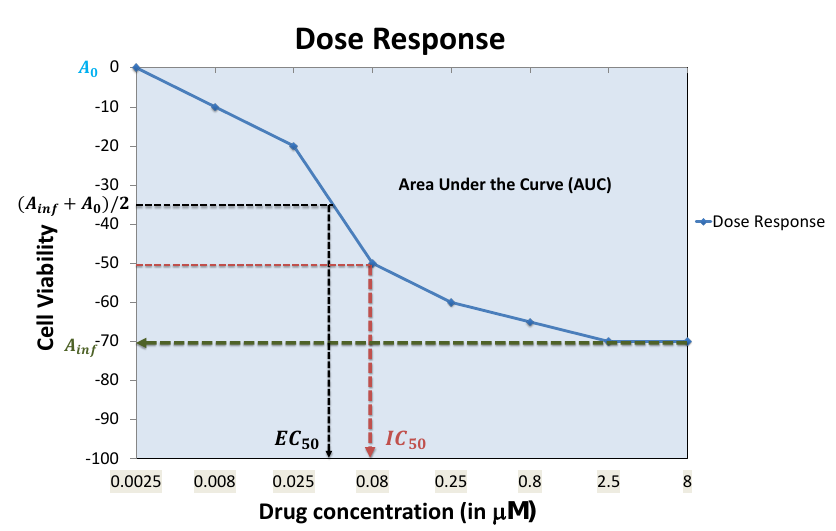
Figure 2. Example dose response curve with commonly-used curve